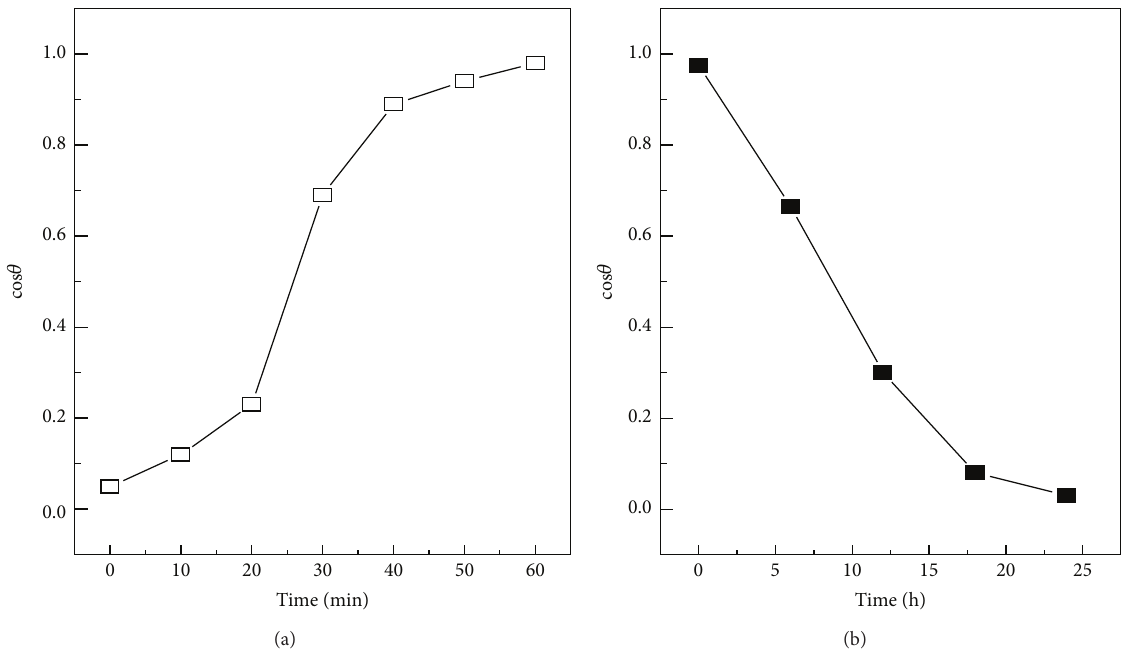
Figure 4: (a) Kinetics of the hydrophobic-hydrophilic transformation under solar simulated light and (b) kinetics of the dark reverse reaction towards the initial state for PE-TiO 2 (8min) RF air plasma pretreated for 15